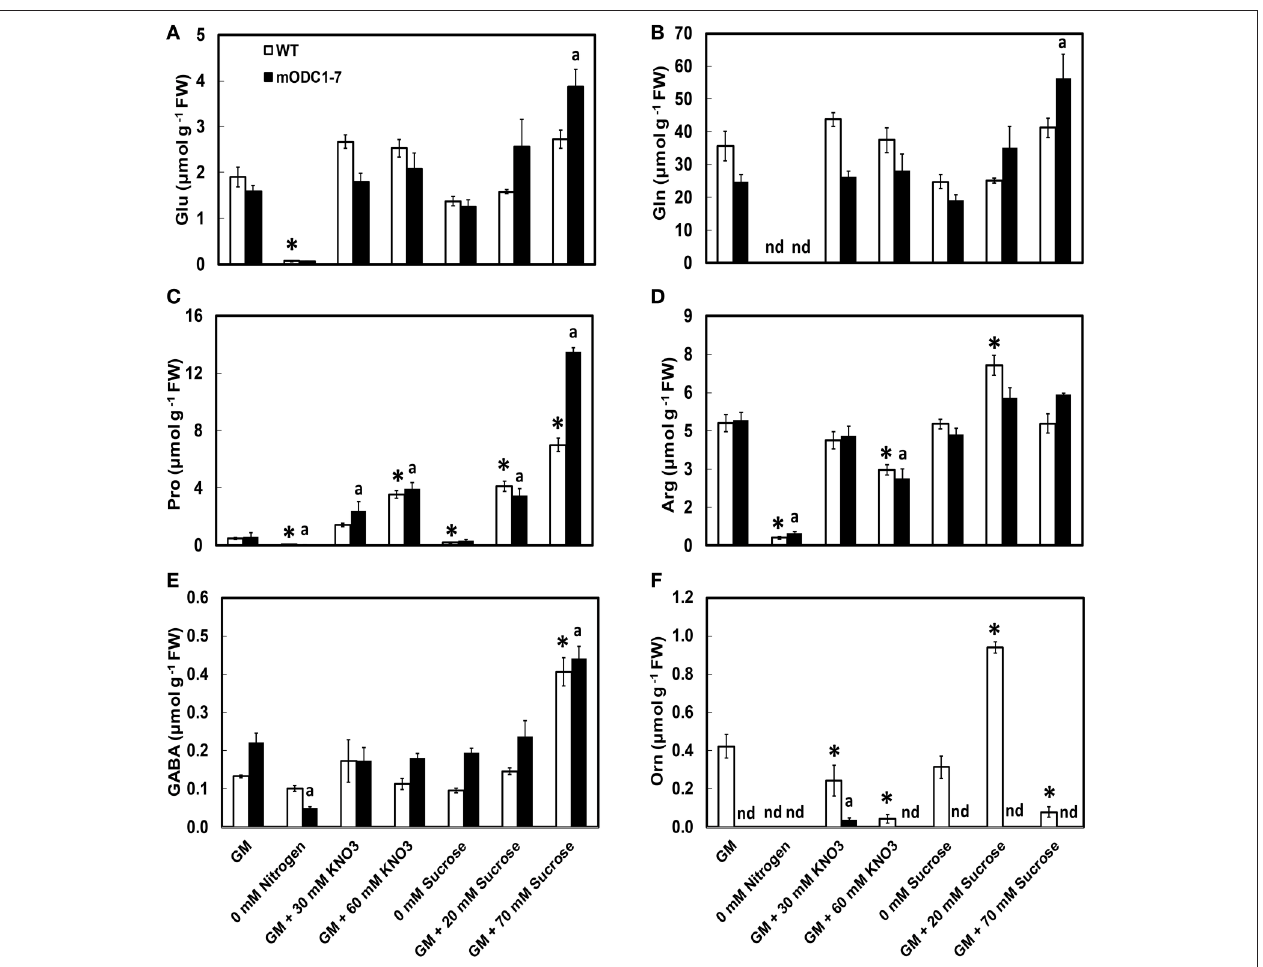
FIGURE 4 | Effects of different concentrations of nitrate and sucrose on PCA soluble amino acids in 12 day old WT and 2x 35S ::m ODC -1-7 Arabidopsis thaliana seedlings. Cellular concentrations of (A) glutamate, (B) glutamine, (C) proline, (D) arginine + threonine + glycine, (E) γ -aminobutyric acid, and (F) ornithine. Data are mean of 4 ± SE; each replicate = 7–8 seedlings. For symbols, see Figure 2